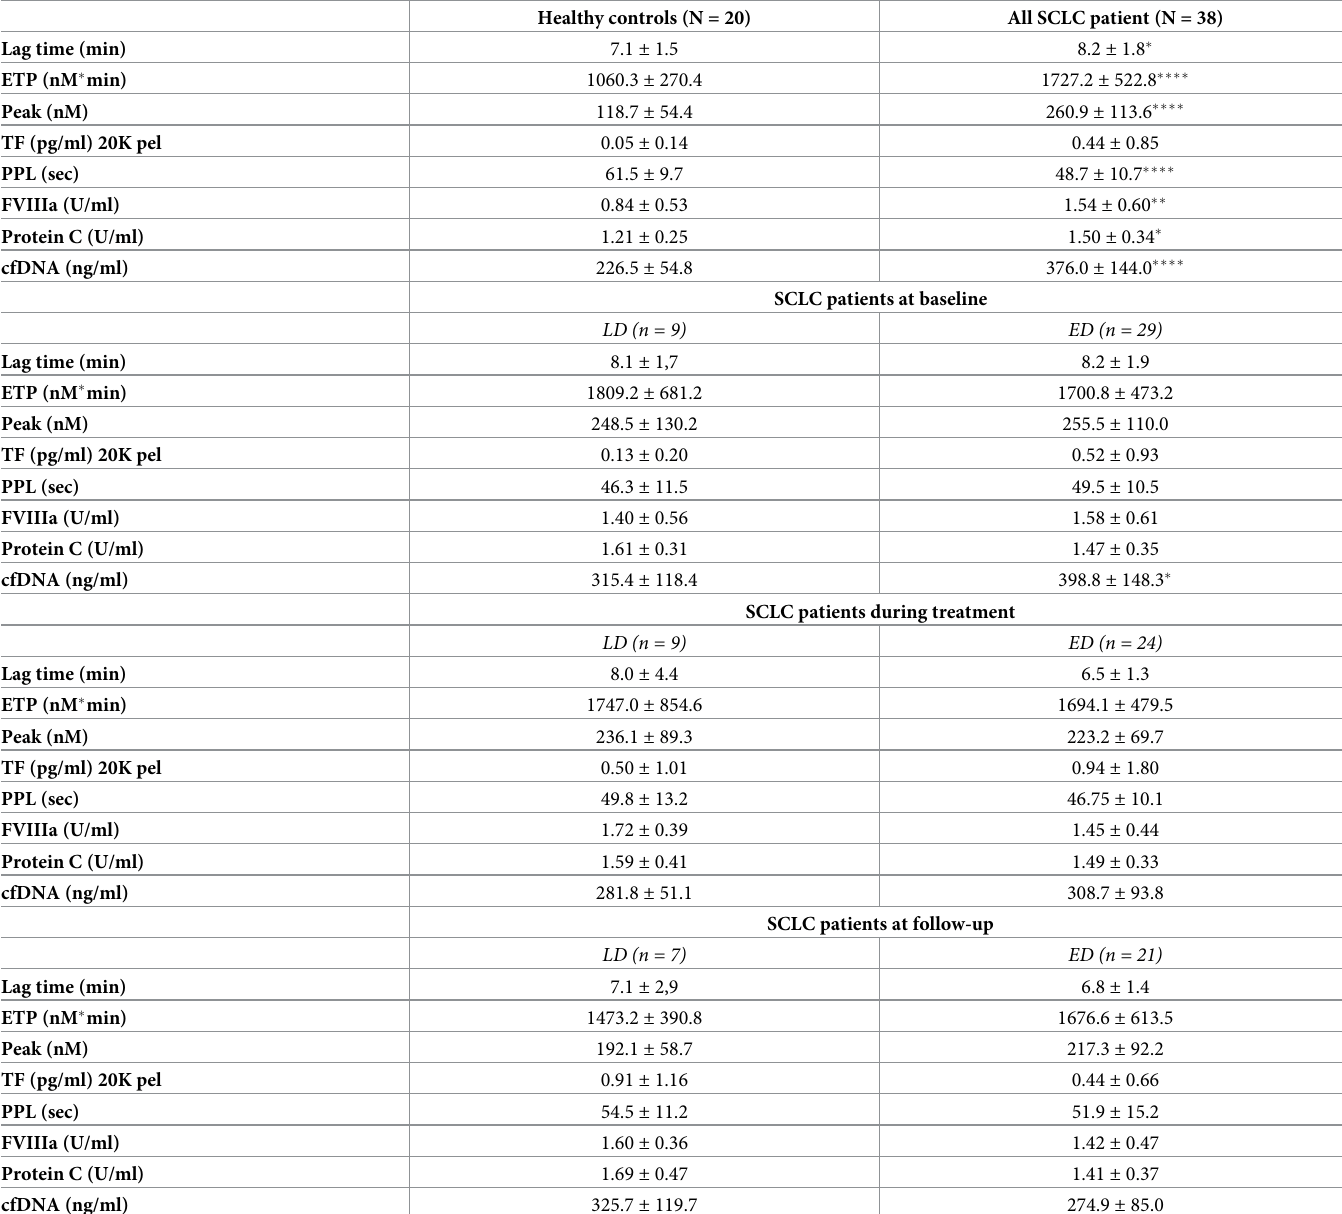
Table 2. Comparison between healthy controls and SCLC patients at